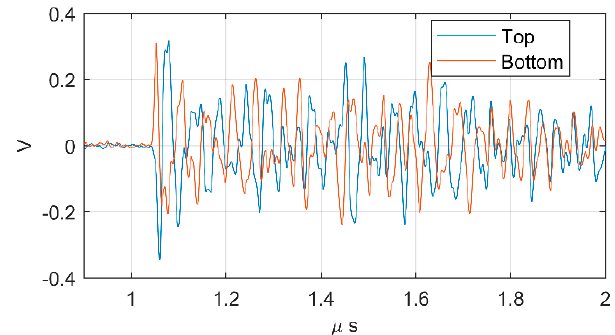
Figure 18. Comparison between the top antenna and the bottom antenna of a measured PD.